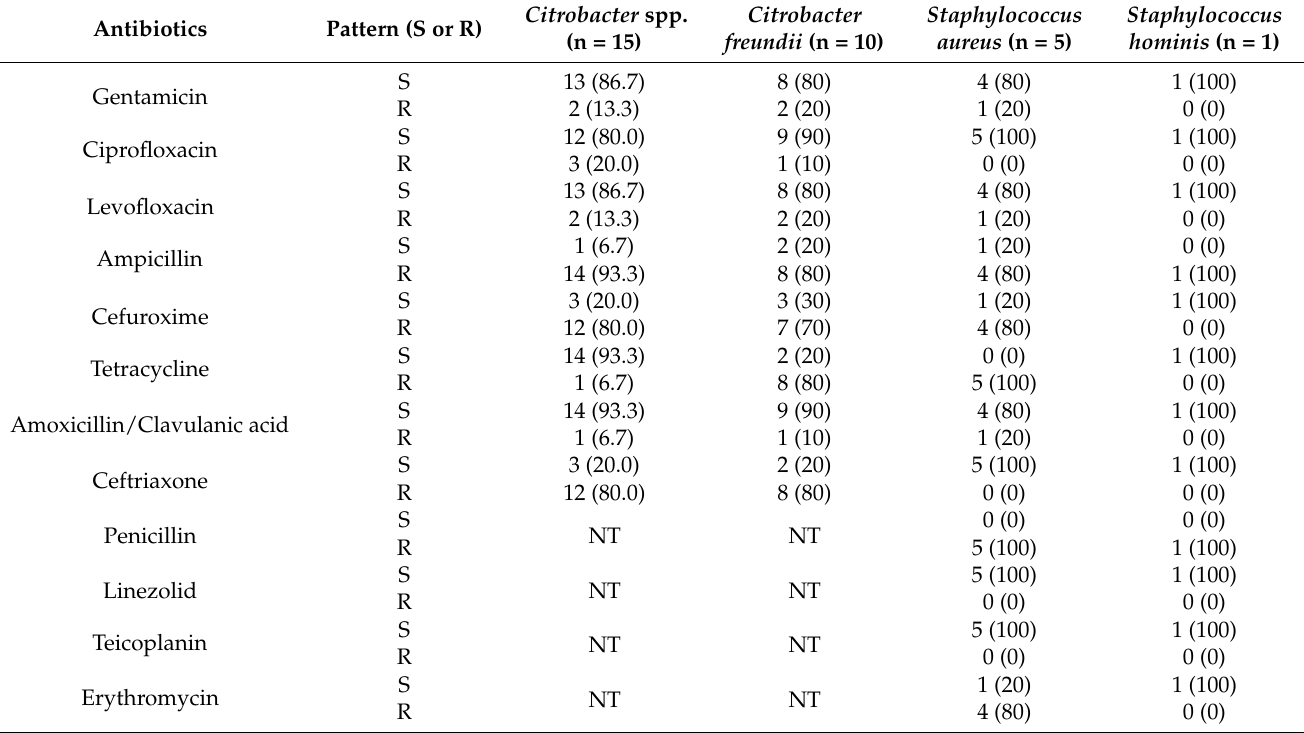
Table 3. In vitro antimicrobial susceptibility pattern of the bacteria isolates.